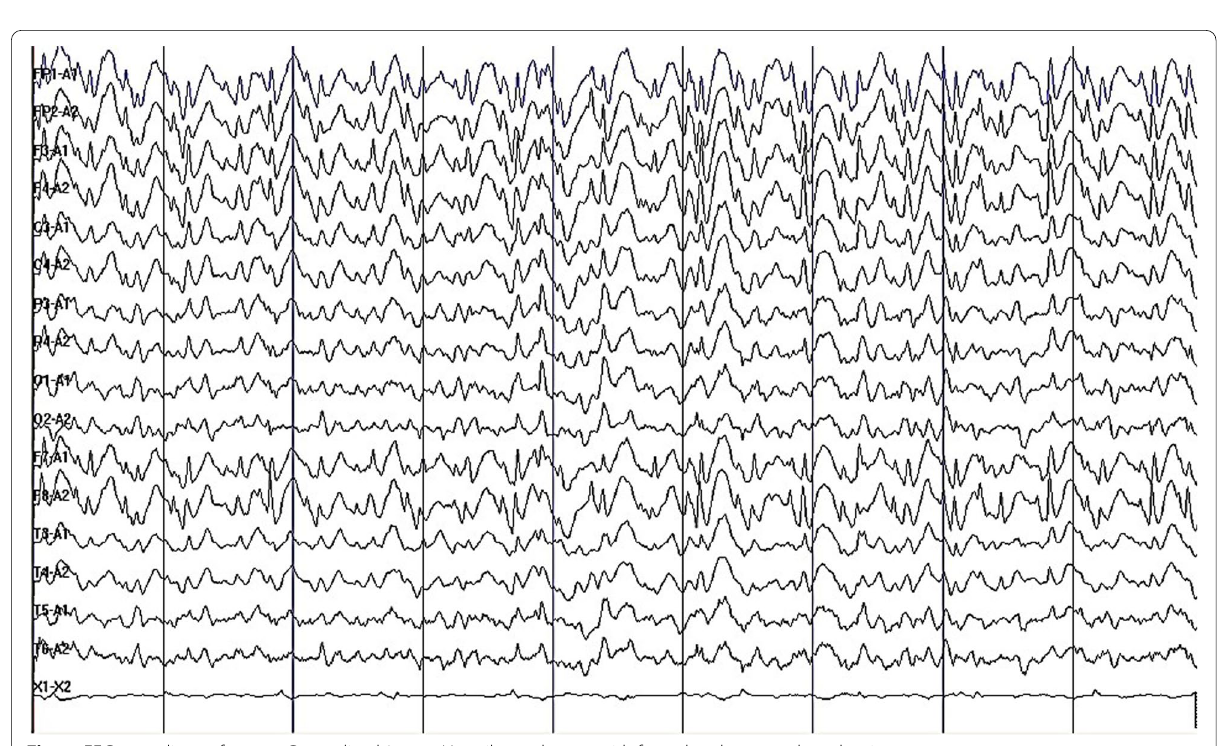
Fig. 4 EEG recordings of case 4. Generalized 3- to 5-Hz spike-and-wave with frontal and temporal